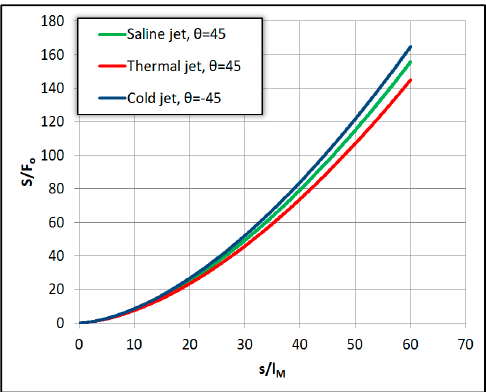
Figure 10. Normalized positively buoyant jet dilution S/F o at θ ο =